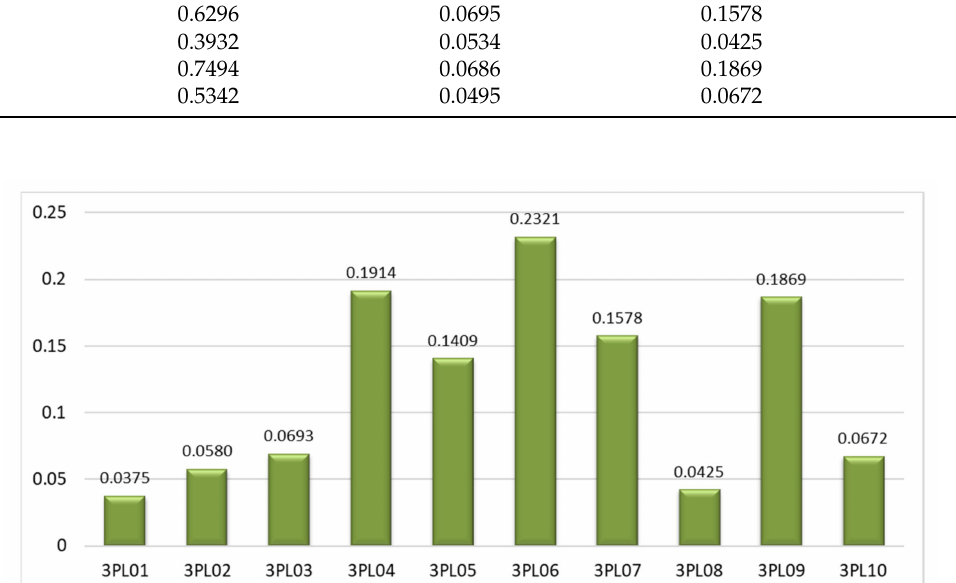
Figure 5. Alternatives ranking of FVIKOR